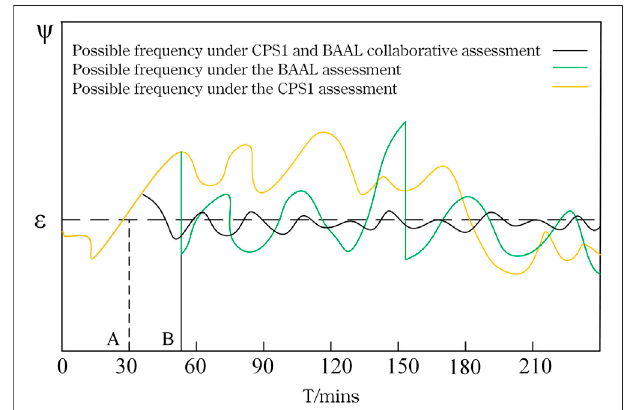
FIGURE 1 | The distribution curve of the integrated frequency deviation factor over